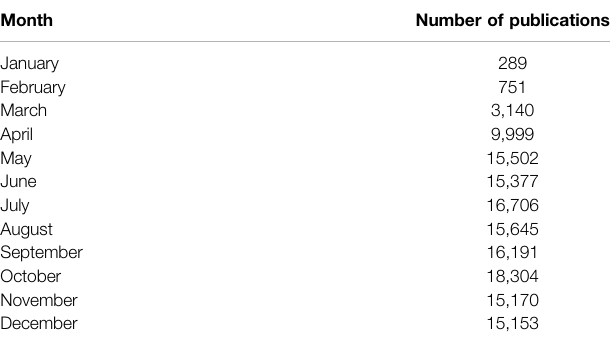
TABLE 1 | Number of COVID-19 research publications including journal articles, preprints, monographs and book chapters by month during 2020 in the dimensions